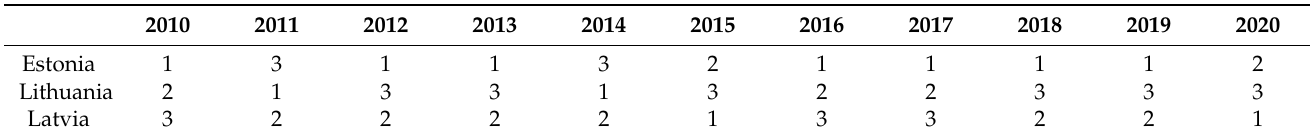
Table 5. Assessment of the investment attractiveness of the Baltic states based on the TOPSIS method (with equal weight